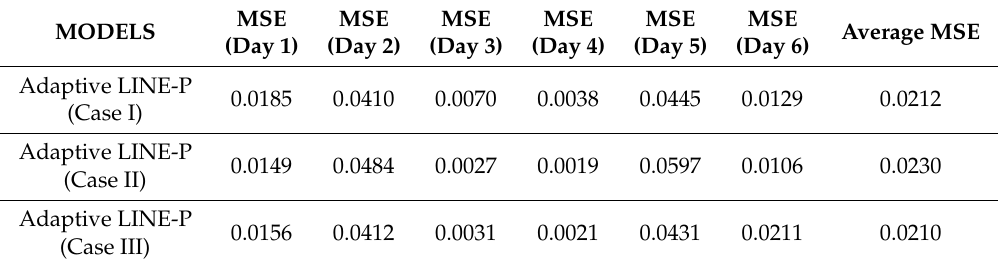
Table 5. Error comparison of adaptive LINE-P (all cases) based on the MSE for Elia wind energy